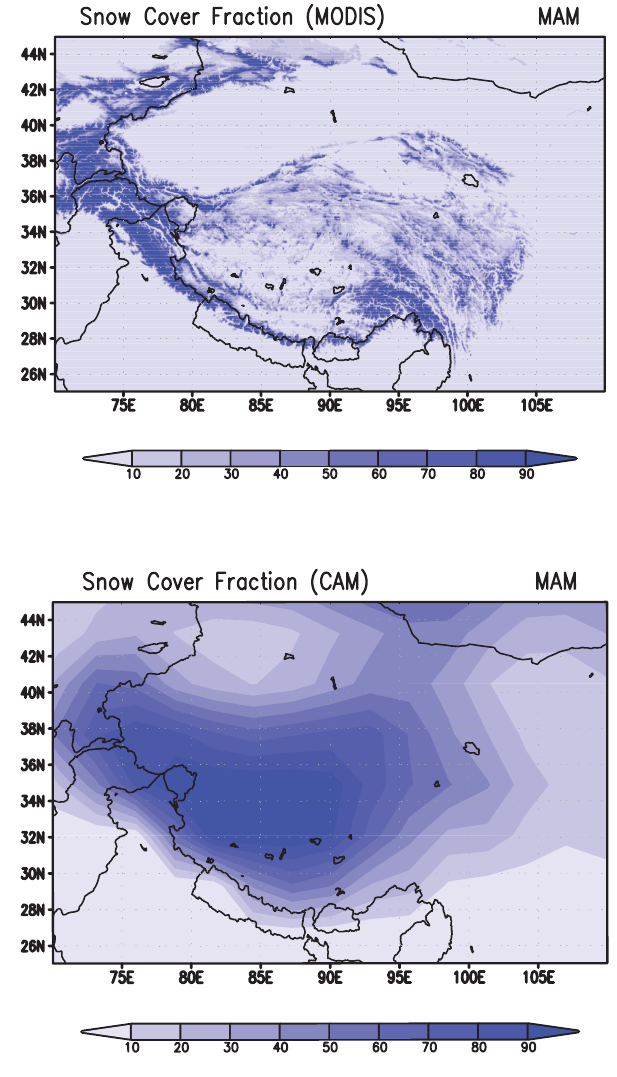
Fig. 2. Snow Cover Fraction (SCF) averaged for March-April-May (MAM) over Tibetan Plateau, (top) MODIS and (bottom) Model.